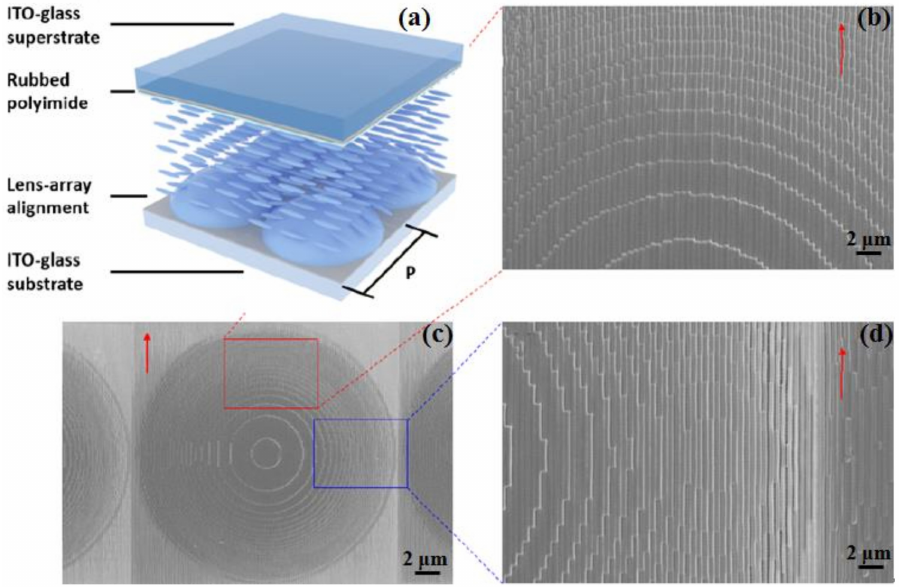
Figure 11. ( a ) Schematic diagram of the adjustable microlens array; and ( b–d ) the SEM images of the prepared microlens array